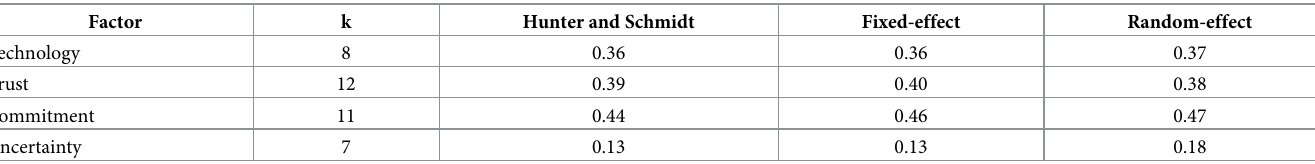
Table 7. Partial correlation